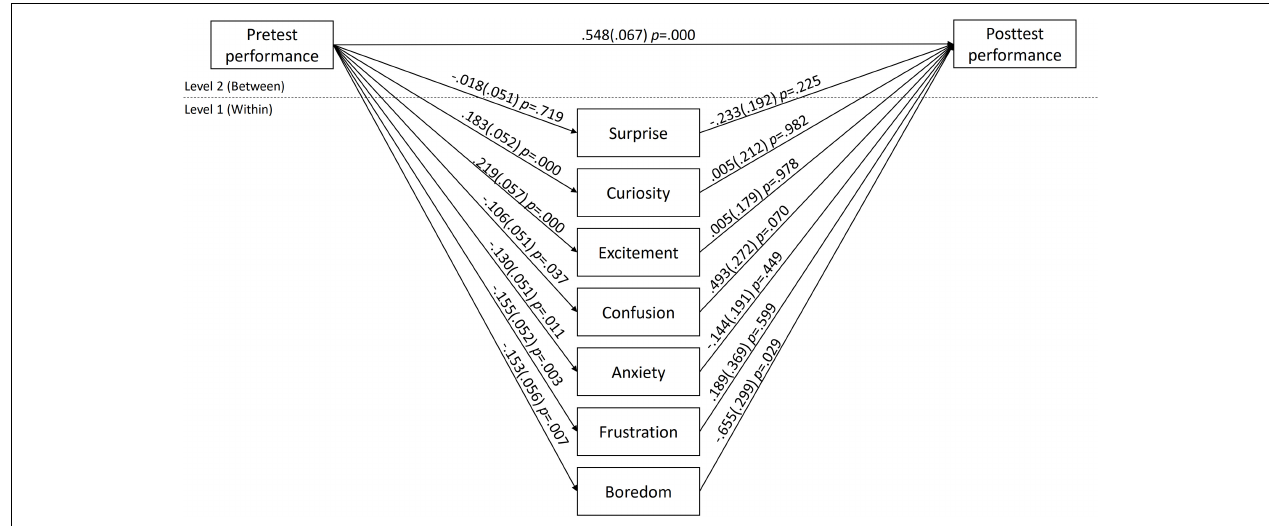
FIGURE 4 | The MSEM with epistemic emotions as parallel mediators between prior knowledge and learning outcome. Regression coefficients correspond to standardized parameter estimates β (standard errors S.E. in parentheses). The mediator residuals were allowed to covary both in the within and between level, the arrows representing the residual covariance were omitted for